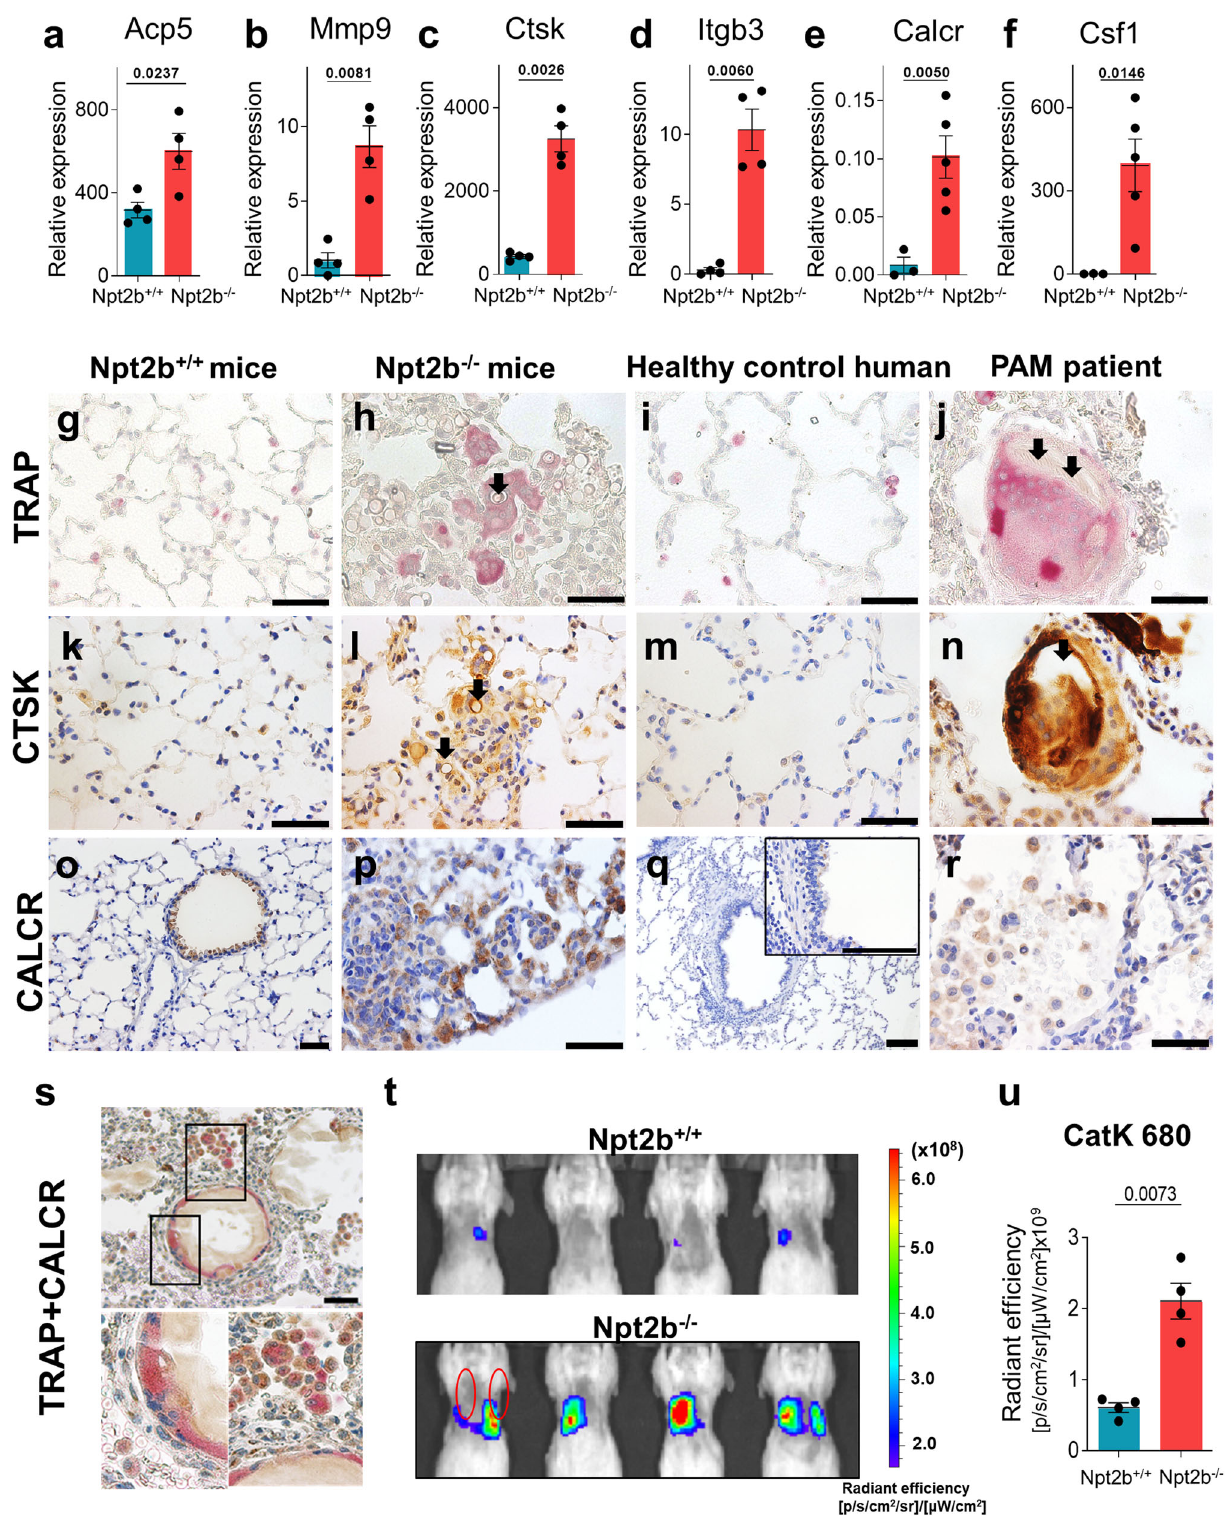
Fig. 4 | Genetic, immunohistochemical, enzymatic and functional evidence of osteoclast activity in PAM lung. a – f Relative expression of osteoclast-related genes in the BAL cells from 8- to 10-week-old Npt2b +/+ and Npt2b − / − mice were determined by RT-PCR. n =4 mice per group ( a – d ), or n =3 for Npt2b +/+ mice and n =5forNpt2b − / − mice( e , f ). g – s Lungsectionsof8-to10-week-oldNpt2b +/+ ( g , k , o ) and Npt2b − / − mice( h , l , p ) and a humancontrol ( i , m , q ) and PAMpatient ( j , n , r , s ) were fi xed and stained for TRAP ( g – j ), CTSK ( k – n ), CALCR ( o – r ) or co-staining of